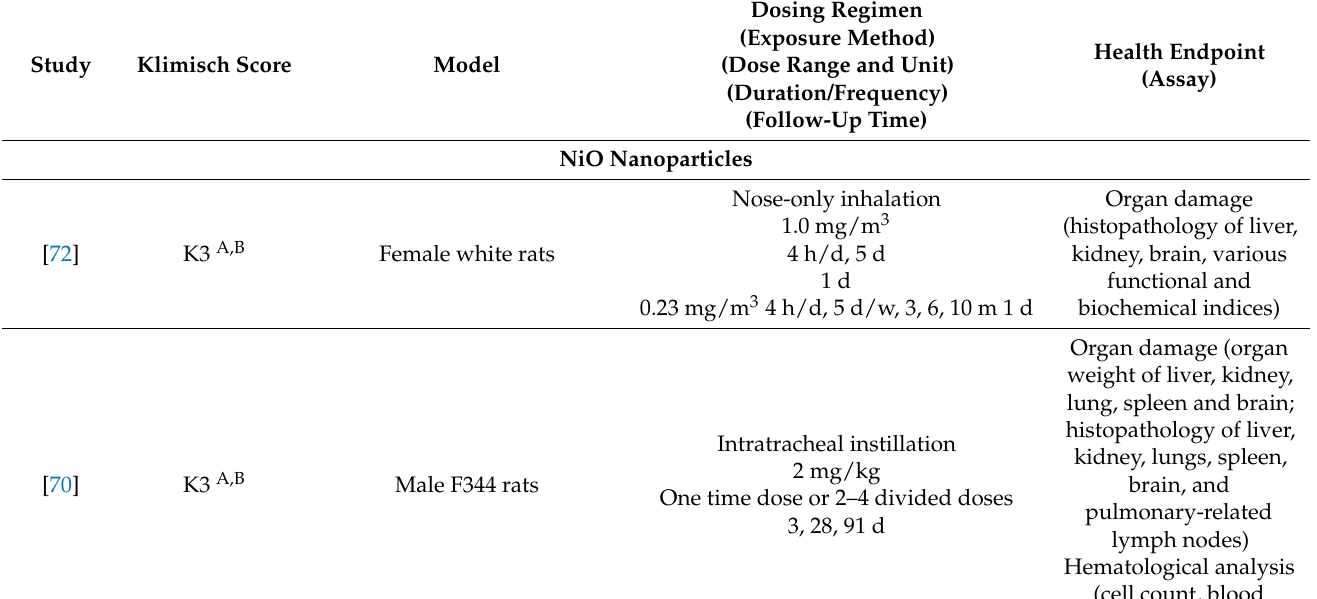
Table 3. In vivo literature associated with systemic endpoints after exposure to oxidic nickel nanoparticles. Studies are arranged by nanoparticle type, followed by exposure